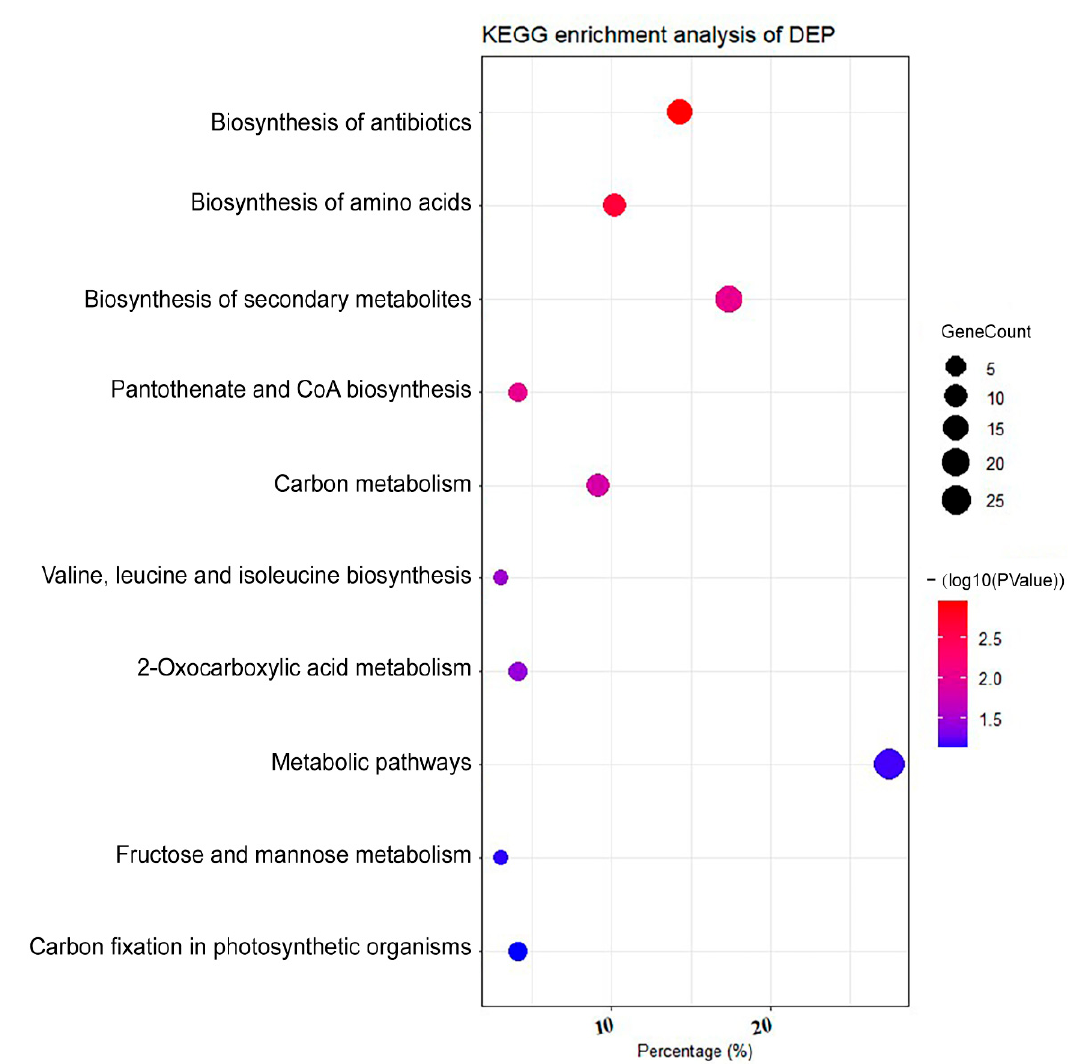
Figure 4. KEGG pathway enrichment result for Chromochloris zofingiensis with or without the presence of glucose. The red–purple color scheme represents the p value and the circle size indicates the number of analyzed proteins.